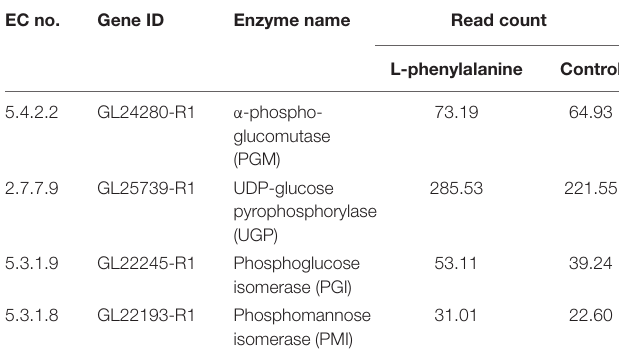
TABLE 2 | The expression of genes related to polysaccharide